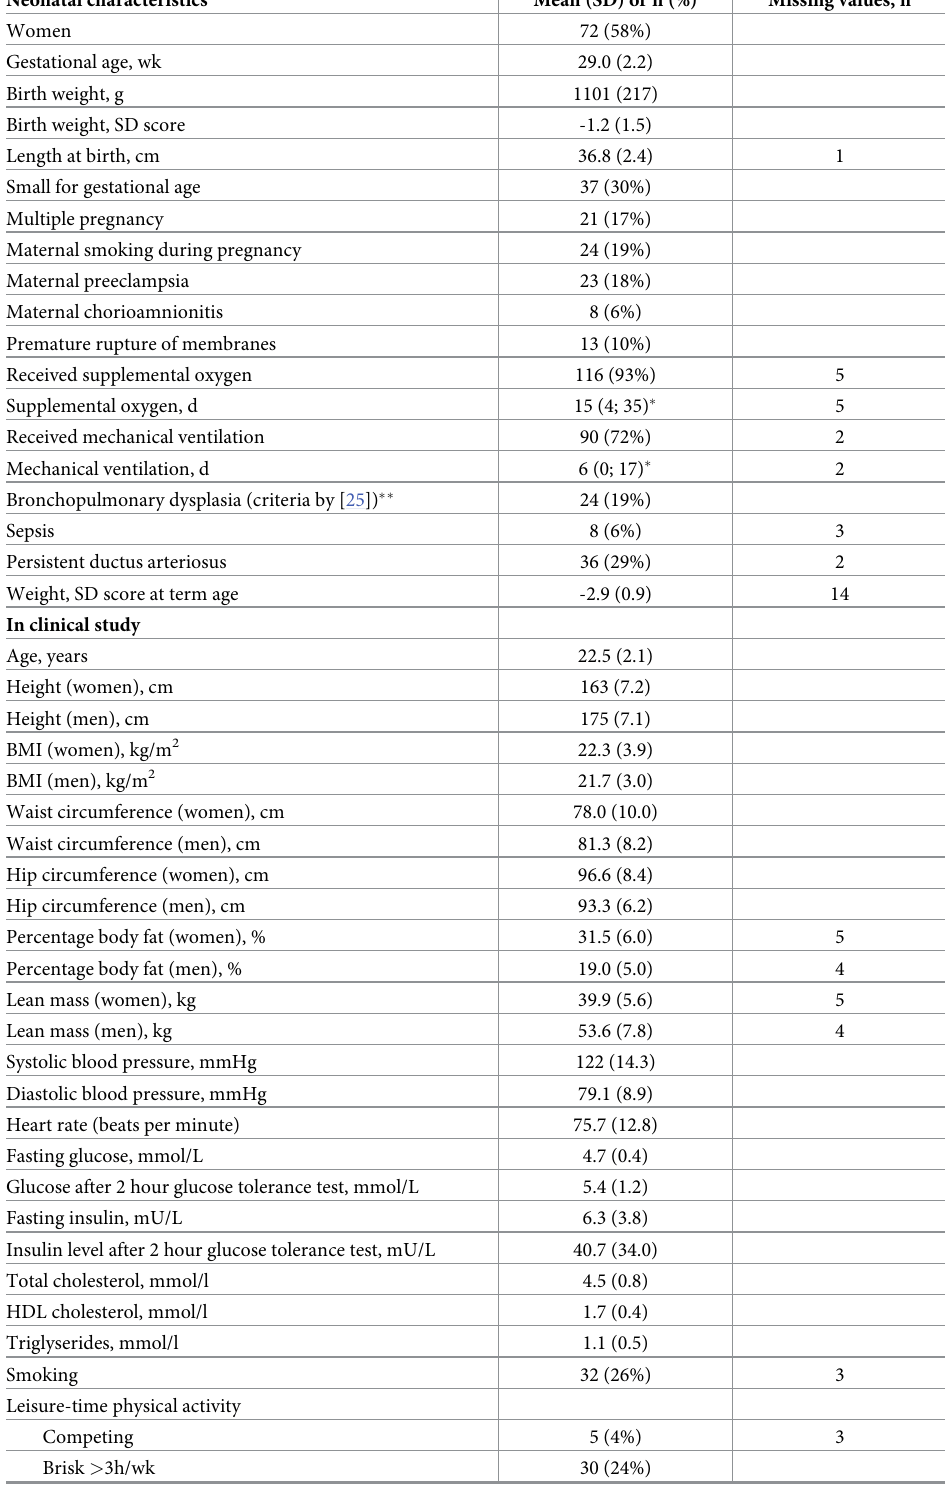
Table 2. Characteristics of the young adults born at